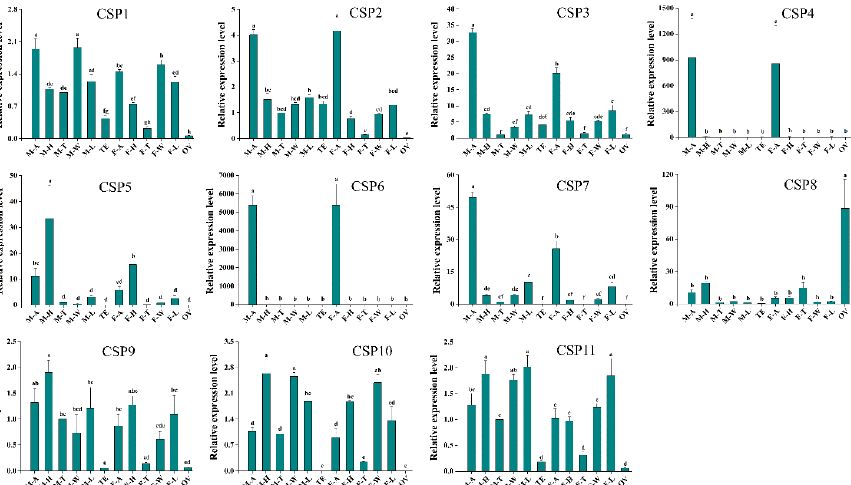
Figure 5. CSP expression patterns in different O. communa male and female tissues. All expression fold changes are related to male thoraxes. M-A, male antennae; M-H, male heads; M-T, male thoraxes; M-W, male wings; M-L, male legs; TE, male testis; F-A, female antennae; F-H, female heads; F-T, female thoraxes; F-W, female wings; F-L, female legs; OV, female ovaries. Bars with the same letters are not significantly different from each other ( p > 0.05; LSD test). Each point represents the mean ± SE.